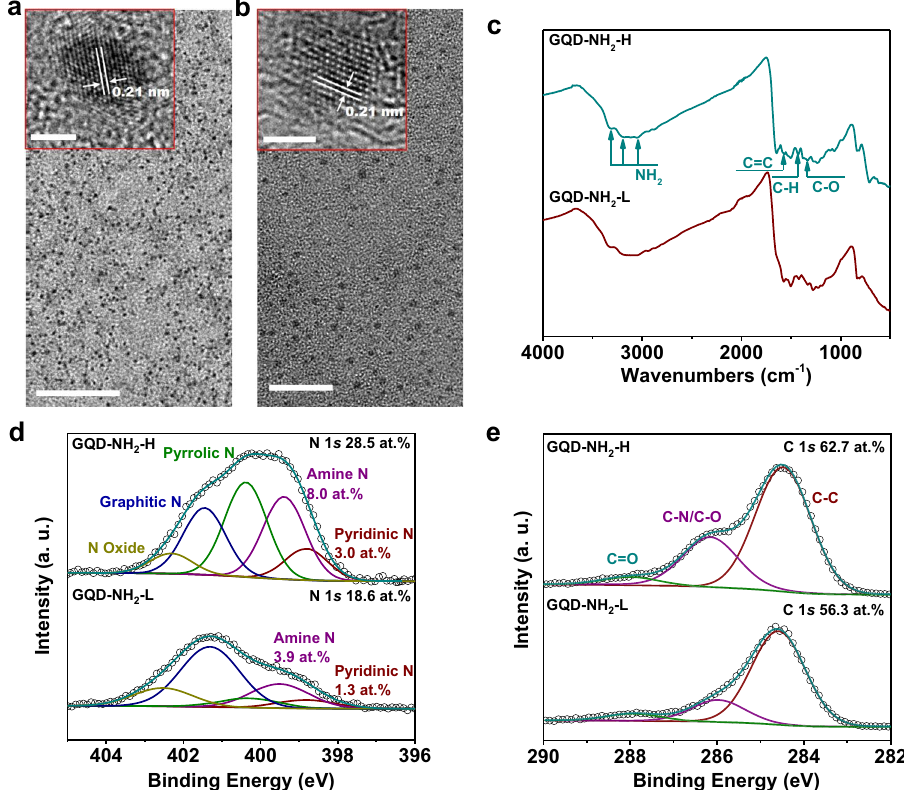
Fig. 3 Characterization results of the two – NH 2 functionalized GQDs. a and b The TEM images and HRTEM images (insets) of GQD-NH 2 -L ( a ) and GQD- NH 2 -H ( b ), respectively. Scale bar: 50 nm for the TEM in Fig. 3a, 20 nm for the TEM in Fig. 3b, and 2 nm for the HRTEM in Fig. 3a and b . c FTIR spectra of GQD-NH 2 -L and GQD-NH 2 -H, showing the existence of – NH 2 functional group. d and e High-resolution N 1 s ( d ) and C 1 s ( e ) spectra of GQD-NH 2 -L and GQD-NH 2